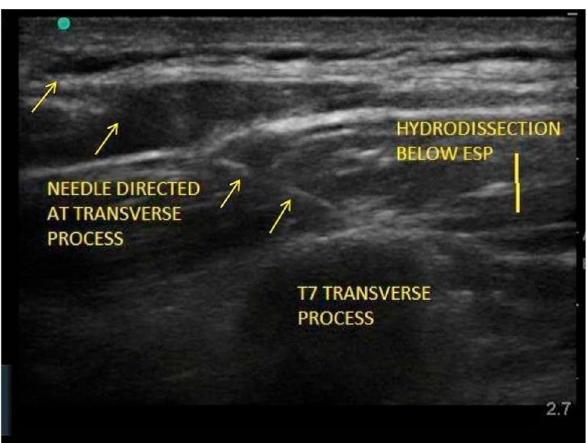
Figure 1: Figureshowingneedleaimingfor thetraverseprocessand showing the hydrodissection fi gure used under a creative commons licence by Ayub et al.